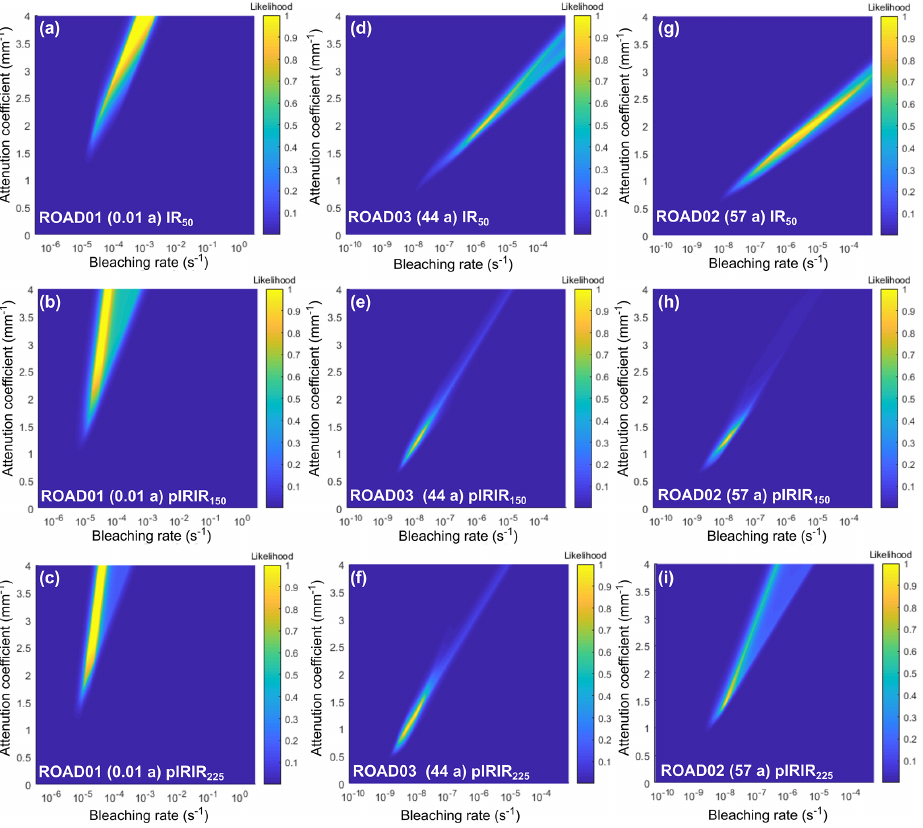
Figure 6. Presented in age order is the relationship between σϕ 0 and µ parameters for ROAD01 (a–c) , ROAD03 (d–f) and ROAD02 (g–i) using the IR 50 (a, d, g) , pIRIR 150 (b, e, h) and pIRIR 225 (c, f, i) signals using the approach of Lehmann et al. (2018). Table 2. Calibration factors determined by fitting depth profiles. Note that values presented are median values.